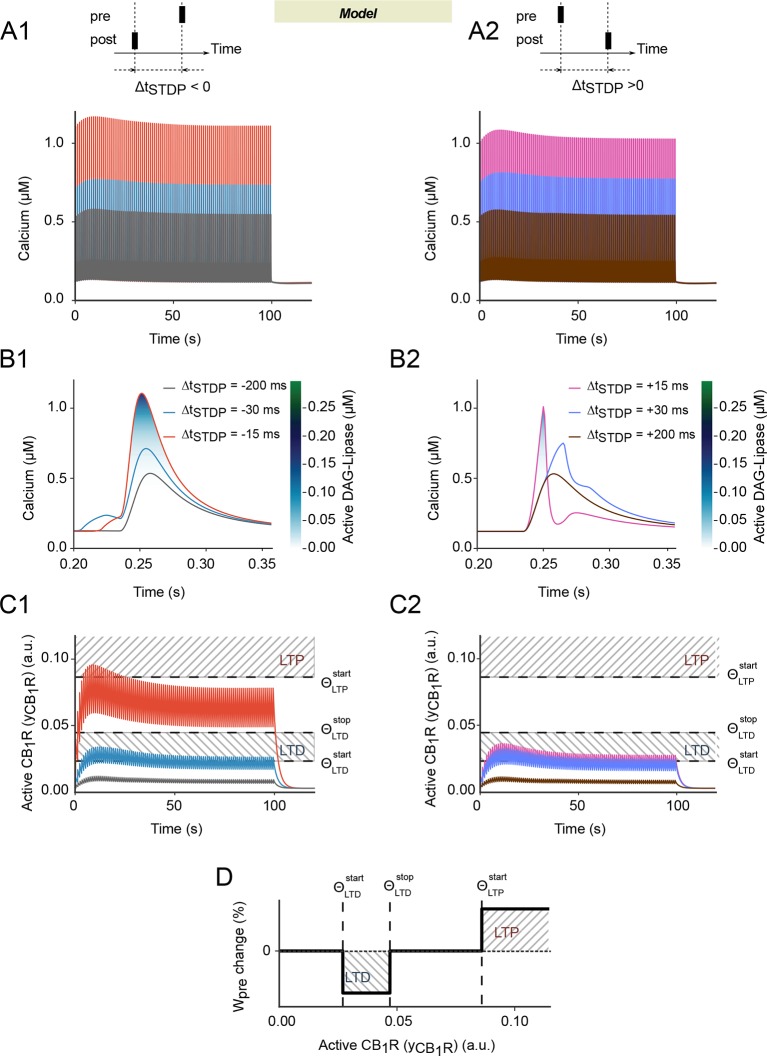
Spike-timing dependence in the endocannabinoid-signaling part of the
model.(A-C) Predicted dynamics of cytoplasmic calcium and CB1R
activation for post-pre (first column) or pre-post pairings (second column):
in our model, the postsynaptic calcium peaks (A, B) are
slightly more width at large calcium values with post-pre
(A1-B1) than pre-post pairings (A2-B2). As a
consequence, DAGLα activation (color-coded in B) and the resulting CB1R
activation, yCB1R (C) is larger
too. The biphasic envelope of the calcium peak amplitude with the number of
pairings (A) is amplified as a marked biphasic envelope for the
amplitude of yCB1R. (C) As a
result, whatever the stimulation, the amplitude of the
yCB1R peaks first increases for the first
10–20 pairings, then decreases to converge to roughly constant amplitude.
But yCB1R reaches large values only for short
post-pre pairings (C1). This particular dynamics of
yCB1R during the stimulations suggests a
possible explanation to the bidirectional characteristics of eCB-dependent
plasticity, where the presynaptic contribution to the synaptic weight
Wpre depends on the magnitude of
yCB1R. (D)
Wpre decreases (LTD) when
yCB1R reaches an intermediate range whereas
it increases (LTP) if yCB1R overcomes a LTP
threshold. The corresponding thresholds and ranges are reported in C1-2 as
dashed lines and hashed boxes, respectively.